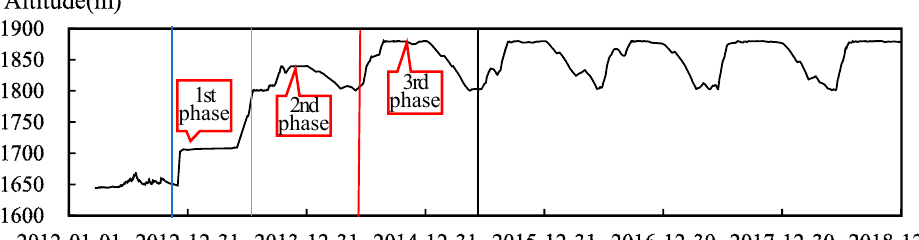
Figure 3. Process diagram of upstream reservoir water level.